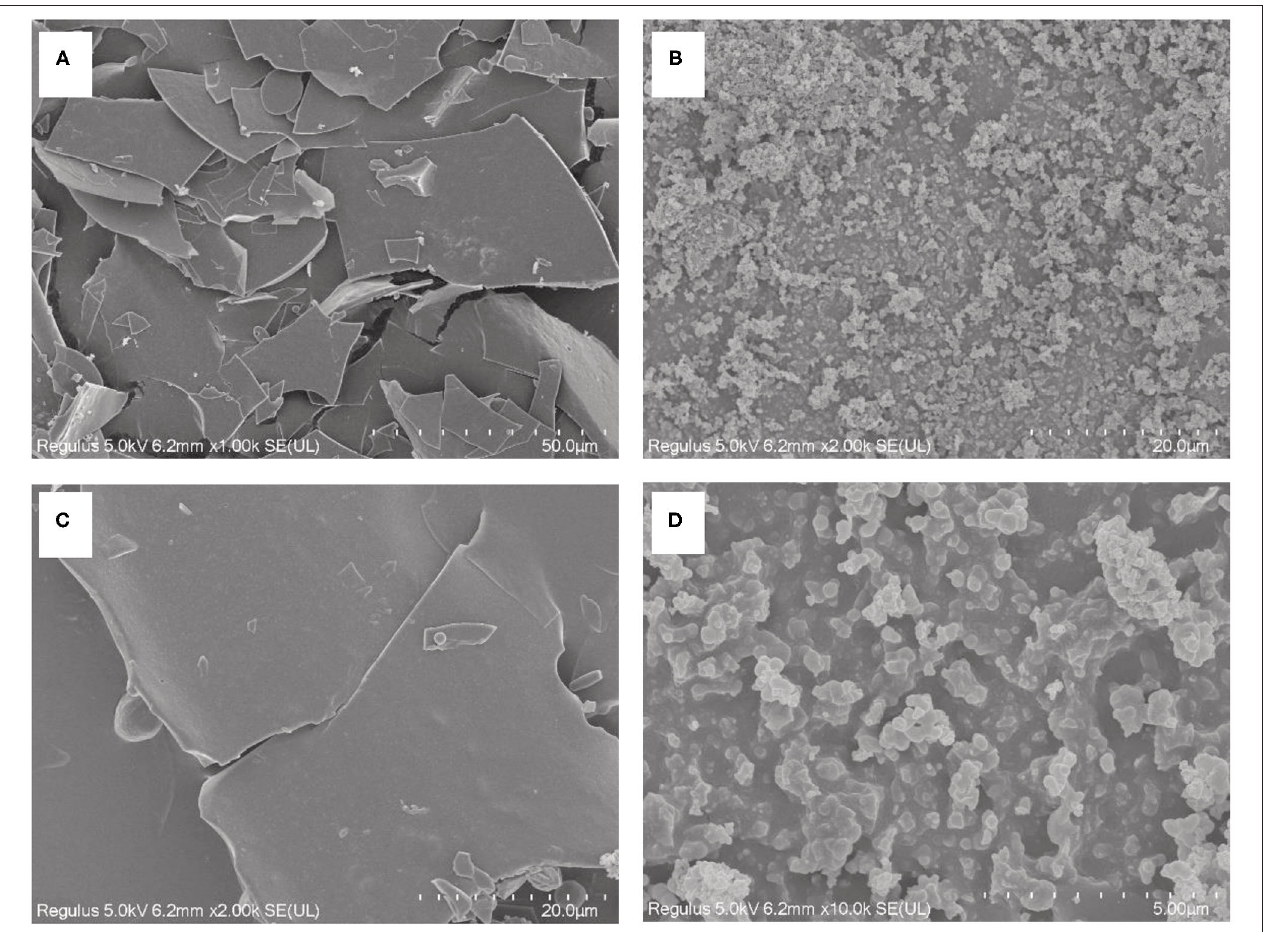
FIGURE 7 | Scanning electron microscopy (SEM) photograph of pumpkin seed protein hydrolysates produced by papain after hydrolysis 3h in a 2% (w/w) enzyme to substrate ratio PSPH-Pap (A, C) and its zinc complex PSPH-Pap-Zn complex (B, D) .